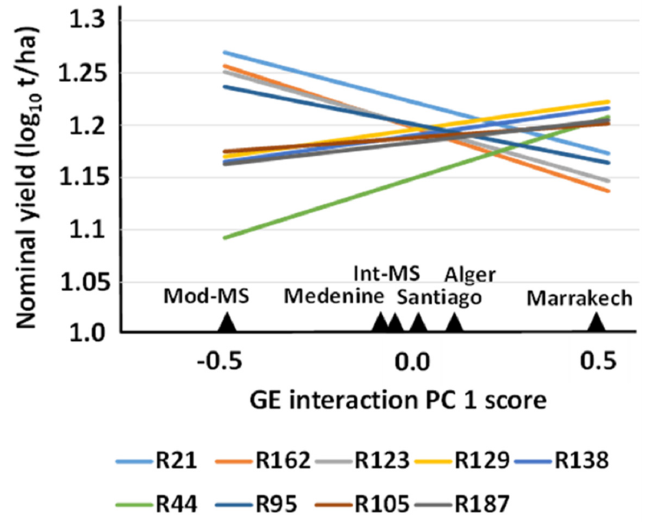
Figure 5. Nominal forage dry matter yield of nine top − yielding lucerne half − sib progenies as a function of the first “genotype × environment” (GE) interaction principal component (PC) across a managed stress (MS) environment in Lodi, Italy (with moderate or intense drought stress), and stress − prone agricultural environments (Médenine, Tunisia; Santiago del Estero, Argentina; Algiers, Algeria; Marrakech, Morocco) in an additive main effects and multiplicative interaction (AMMI) analysis. Source: [46].